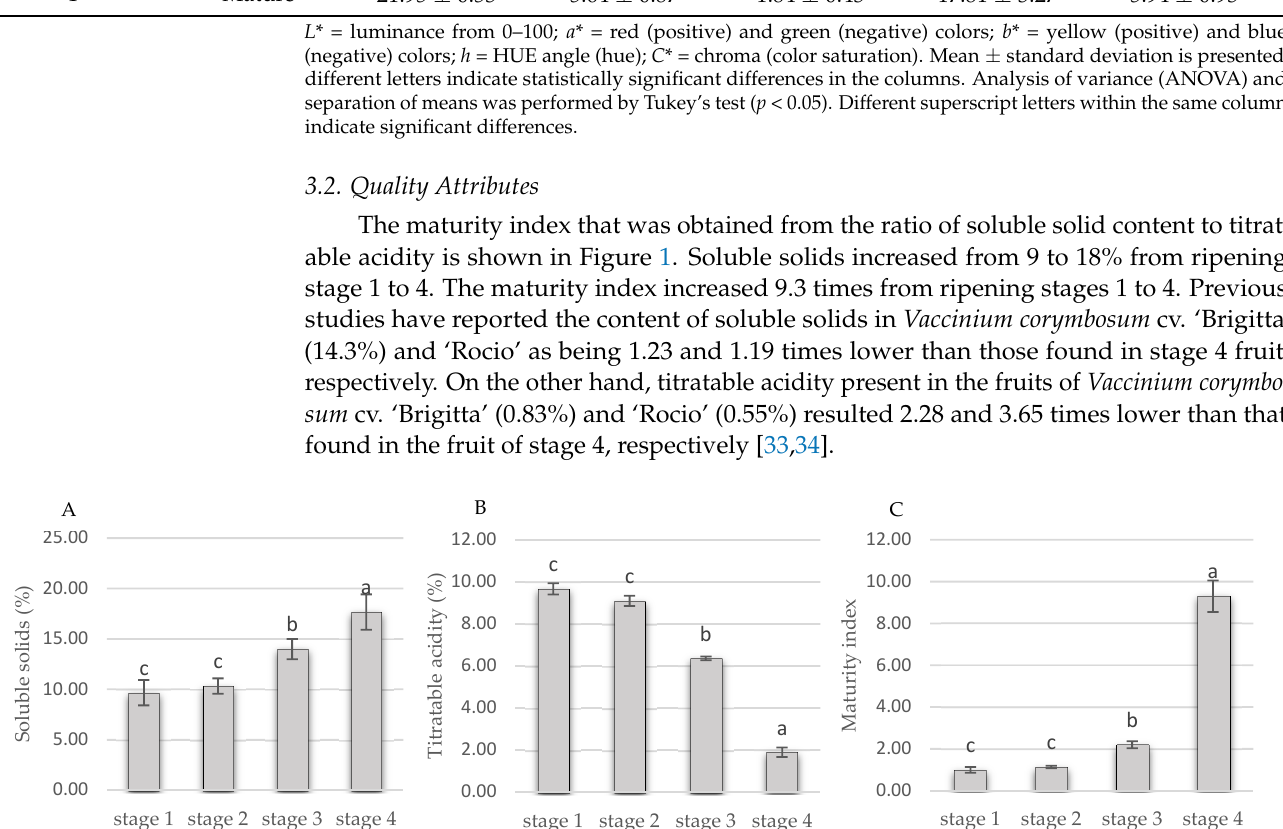
7 of 18 Table 2. Color parameters L *, a *, b *, h and C * for the four ripening stages of Vaccinum stenophyllum Steud. fruit.